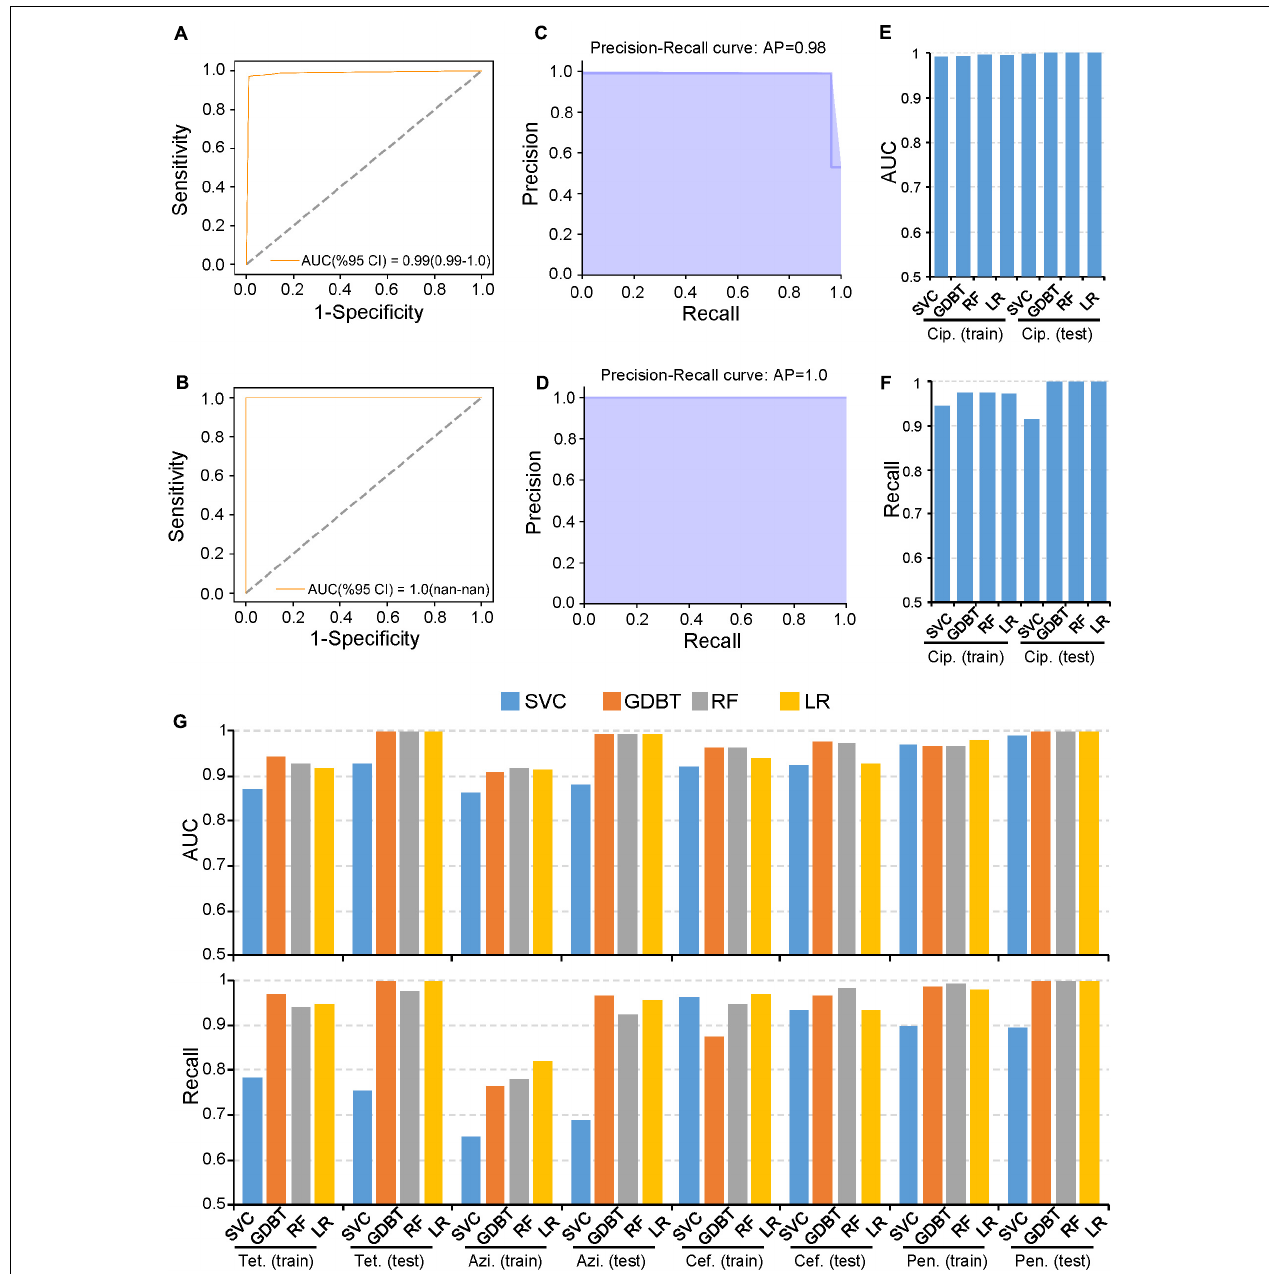
FIGURE 2 | PARMAP (Prediction of Antimicrobial Resistance by MAPping genetic alterations in pan-genome) successfully predicts antimicrobial resistance (AMR), in Neisseria gonorrhoeae . Receiver operating characteristic (ROC), curve for the prediction of ciprofloxacin resistance using the gradient boosting (GDBT), model in the (A) training and (B) testing datasets. Precision-recall (PR), curve for the prediction of ciprofloxacin resistance using the GDBT model in the (C) training and (D) testing datasets. (E) PR curve for the prediction of ciprofloxacin resistance using the GDBT model in the testing dataset. (F) Recall values for ciprofloxacin resistance with different machine learning methods in the training and testing datasets. (G) Area under the curve (AUC), values (upper panel) and Recall values (lower panel) of different machine learning models in the training and testing datasets for tetracycline (Tet.), azithromycin (Azi.), cefixime (Cef.), and penicillin